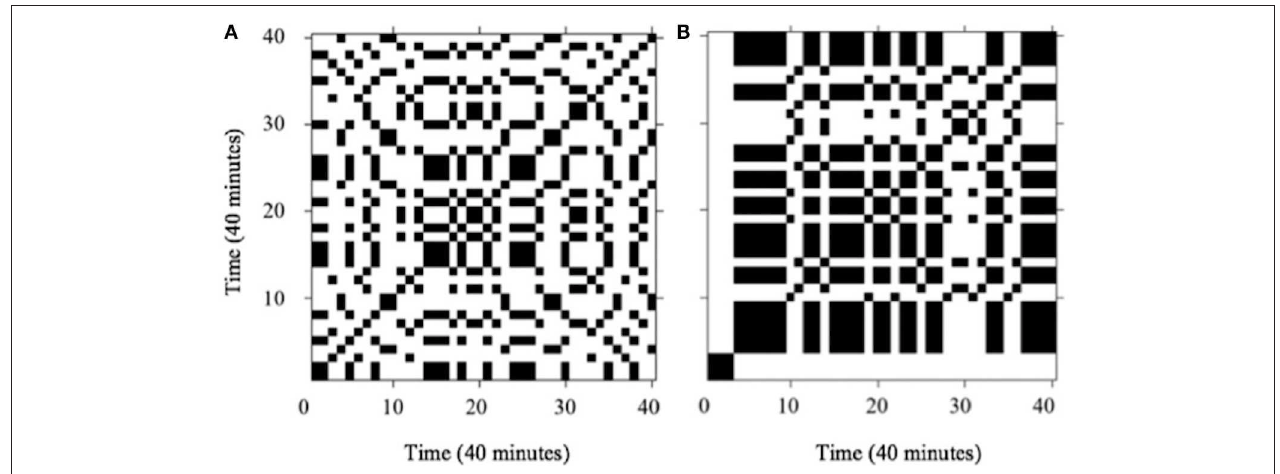
FIGURE 2 | Example JRP for two high performing UAV teams’ interactions (length 40min): (A) control (Determinism: 46%) and (B) synthetic teams (Determinism: 77.6%) (from Demir et al., 2018c; reprinted with